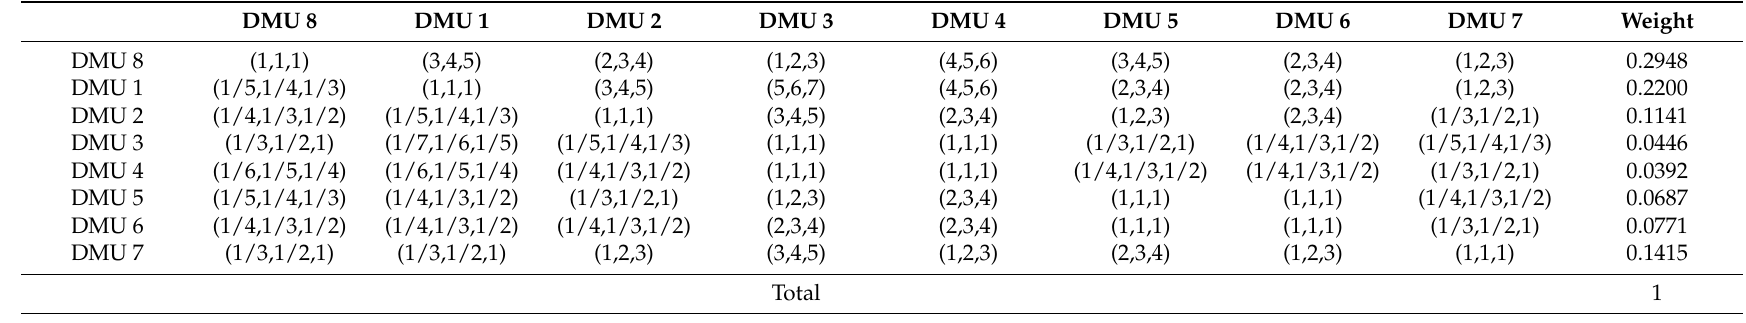
Table A24. Comparison matrix for DEN based on alternatives.